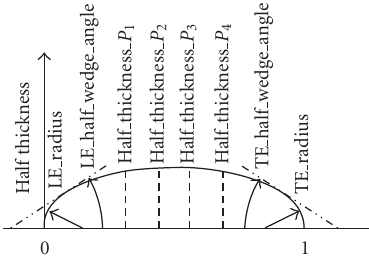
Figure 2: Optimization design system.